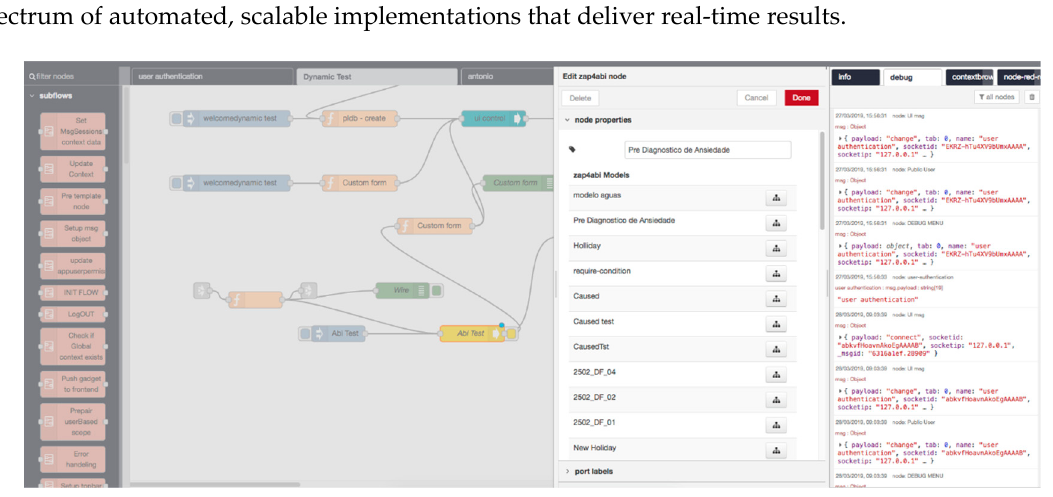
Figure 1. modeling in the